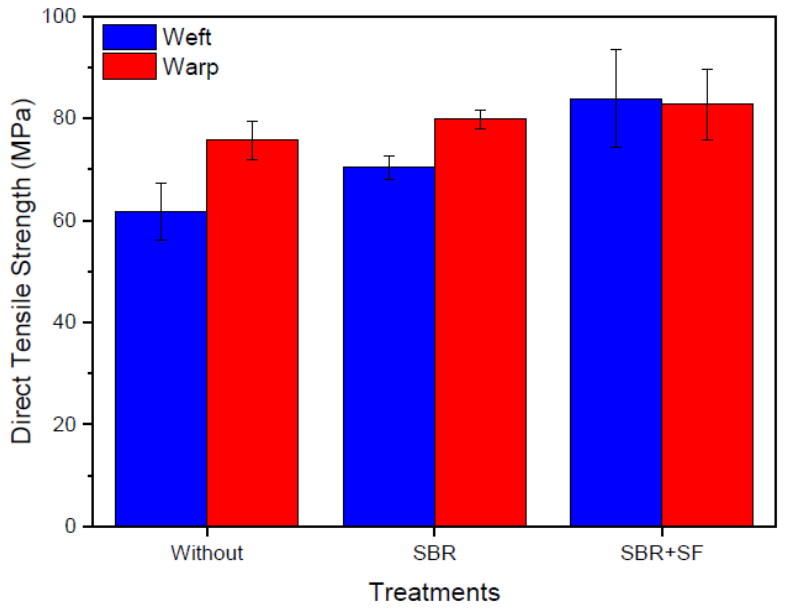
Figure 8. Direct tensile strengths along weft and warp for polyester samples with and without im-